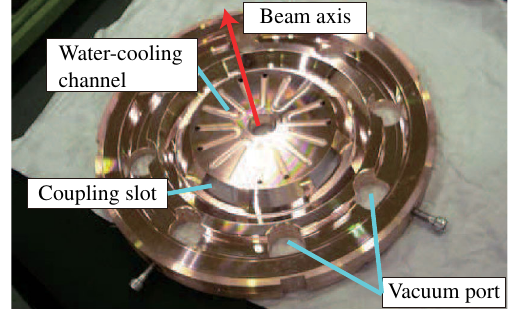
FIG. 2. Half-cell piece of the ACS as viewed from the coupling-cell side (see Fig. 4).